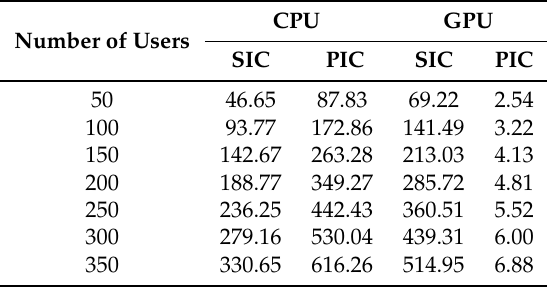
Table 2. Comparison of the computational times of SIC and PIC in ms with an FFT size of 4096.